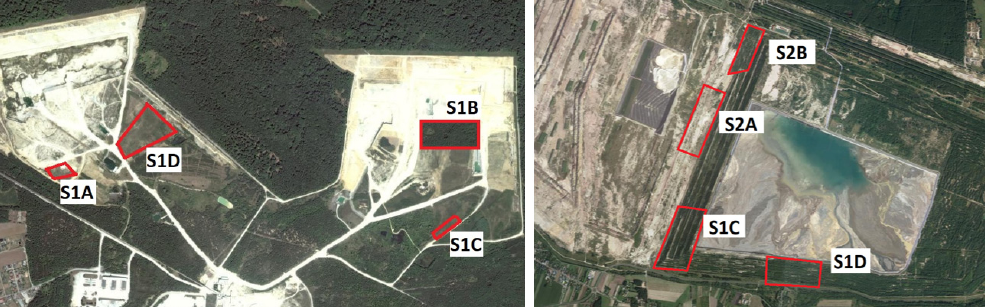
Figure 1. Localization of selected study areas, and sampling scheme. Photos from satellite map. Source: Google Maps.